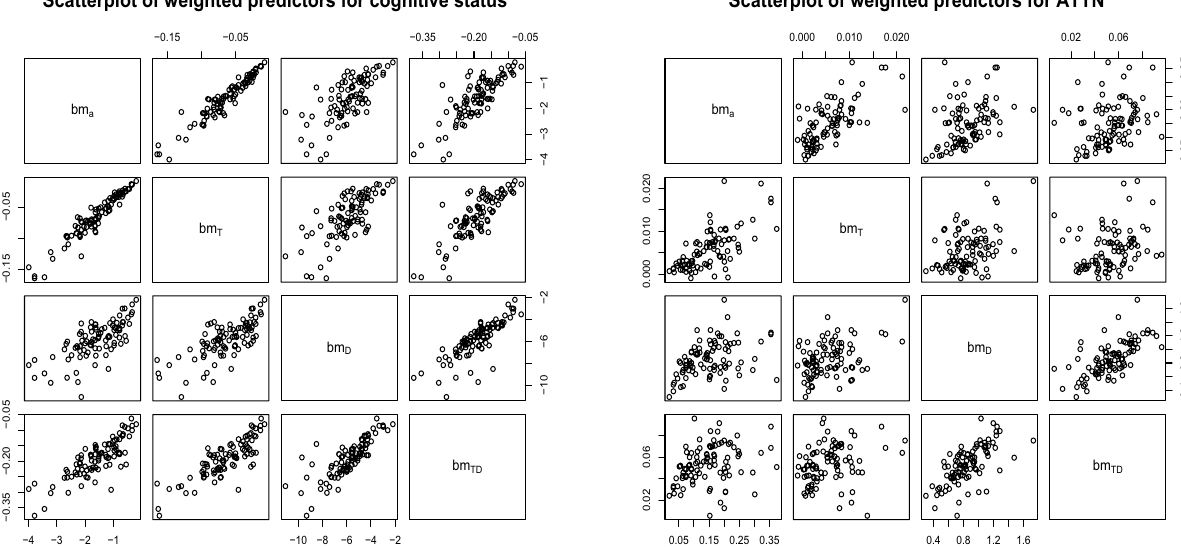
Figure 7. Scatterplots of the estimated weighted scores corresponding to the predictors average PA, diurnal PA curve, PA quantile function and time-by-distribution PA metric respectively for cognitive status (left) and ATTN (right). Note : bm a corresponds to average daily total count, bm T corresponds to temporal curves of PA, bm D corresponds to distribution representation (via quantile functions) of PA and bm TD corresponds to time- by-distribution representation of